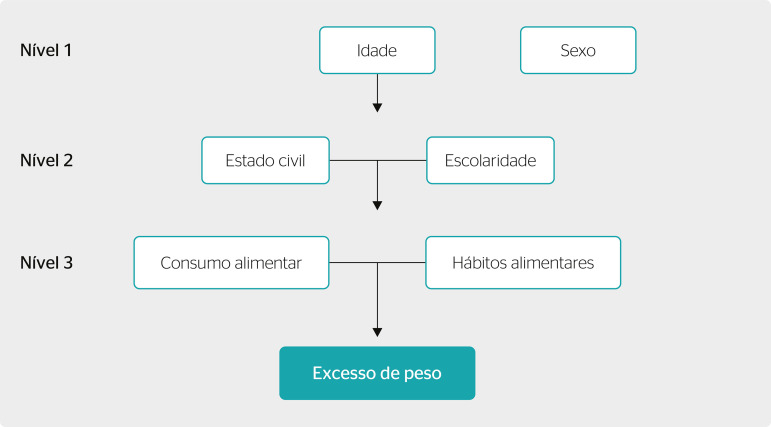
Hierarchical model of the factors associated with overweight of the employees studied.